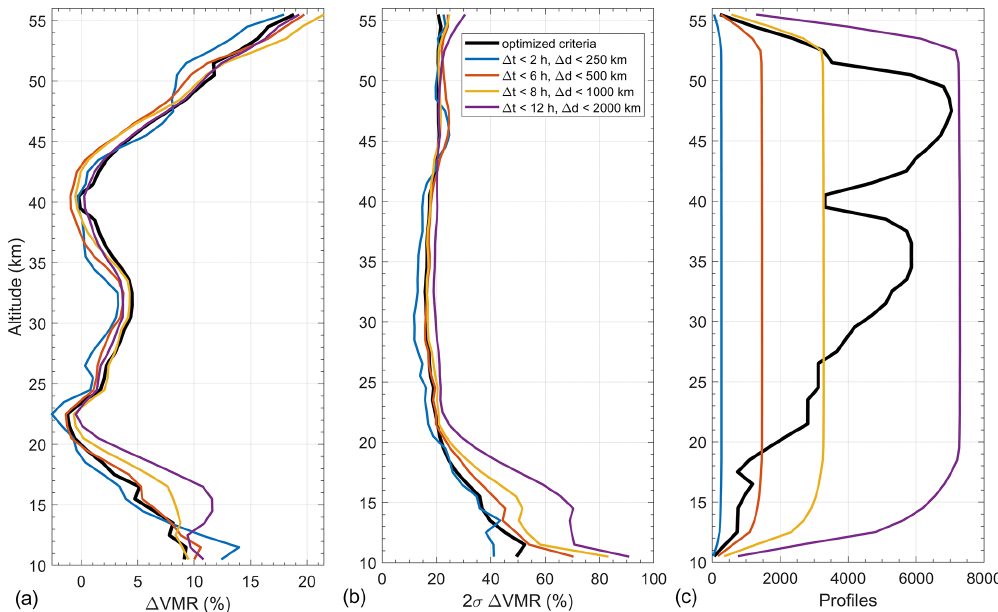
Figure 6. Comparison results between ACE-FTS and OSIRIS O 3 for different coincidence criteria: (a) mean of the relative differences, (b) 2 σ variation of the relative differences, and (c) number of coincident profiles. Optimized criteria are for less than 10% geophysical variability above 17km and less than 15% below